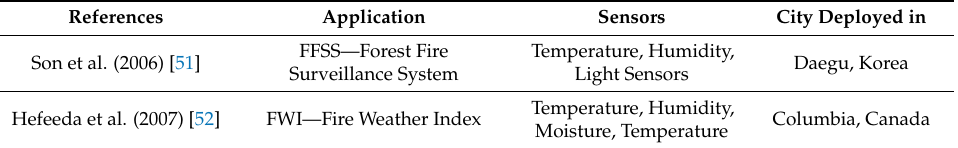
Table 6. Examples of prototyped applications for forest